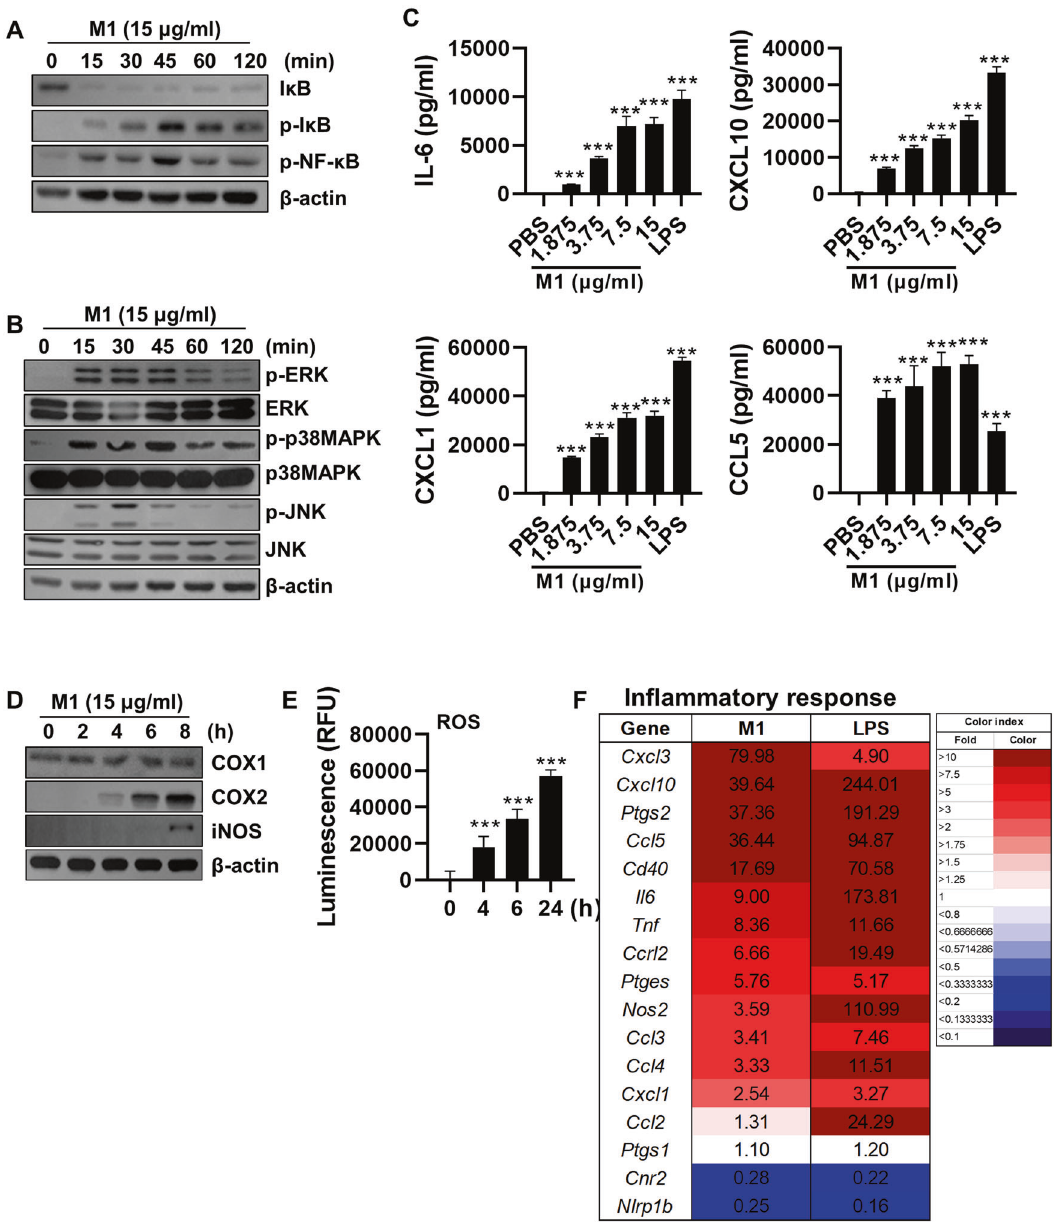
detected in cell culture supernatants of cells treated with rM1 (15 μ g/ml) ( n = 5 ). F The in fl ammatory response genes regulated by M1 and LPS treatment was analyzed by RNA-sequencing is presented as a heatmap ( n = 2 ). Data are presented as the mean ± standard deviation (SD) from triplicate culture wells. *** p <